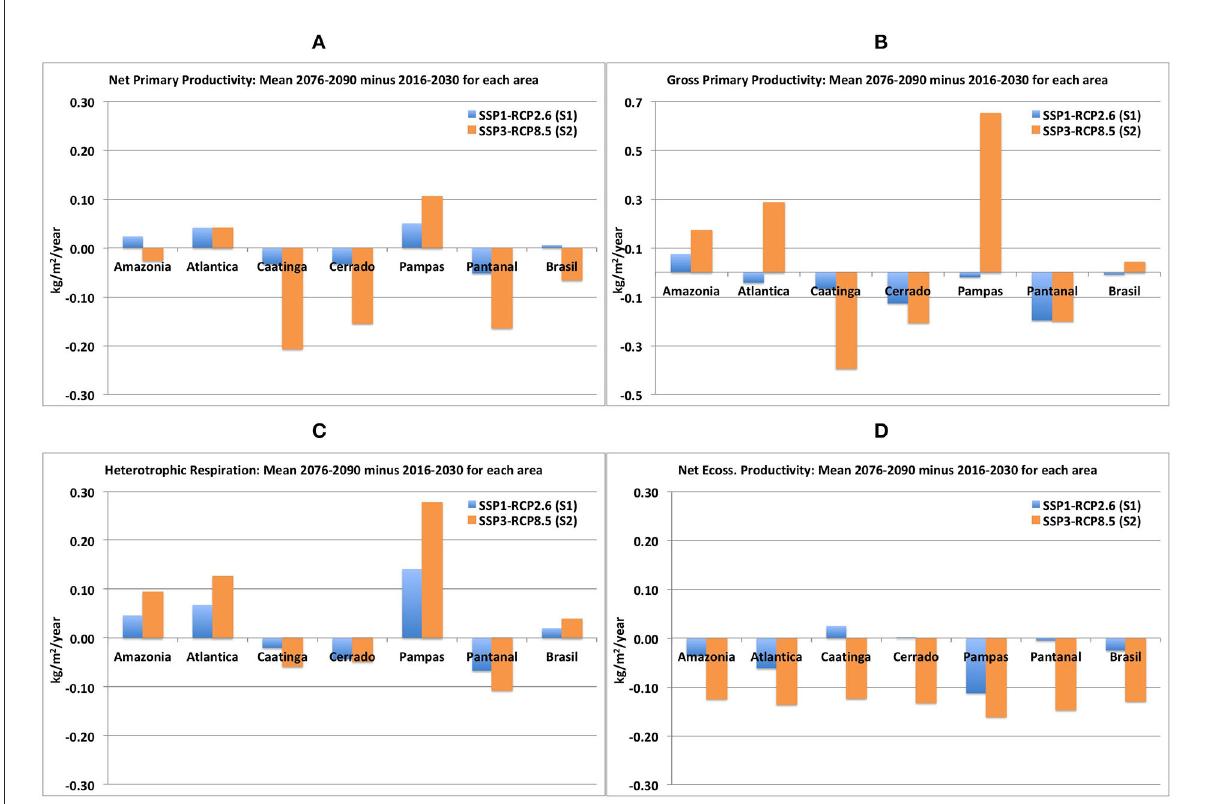
FIGURE8 Difference (kgC/m 2 /year) between the mean of the last and first 15 years of the simulation for each biome for (A) net primary productivity, (B) gross primary productivity, (C) heterotrophic respiration, and (D) net ecosystem productivity for S1 (blue bars) and S2 (orange